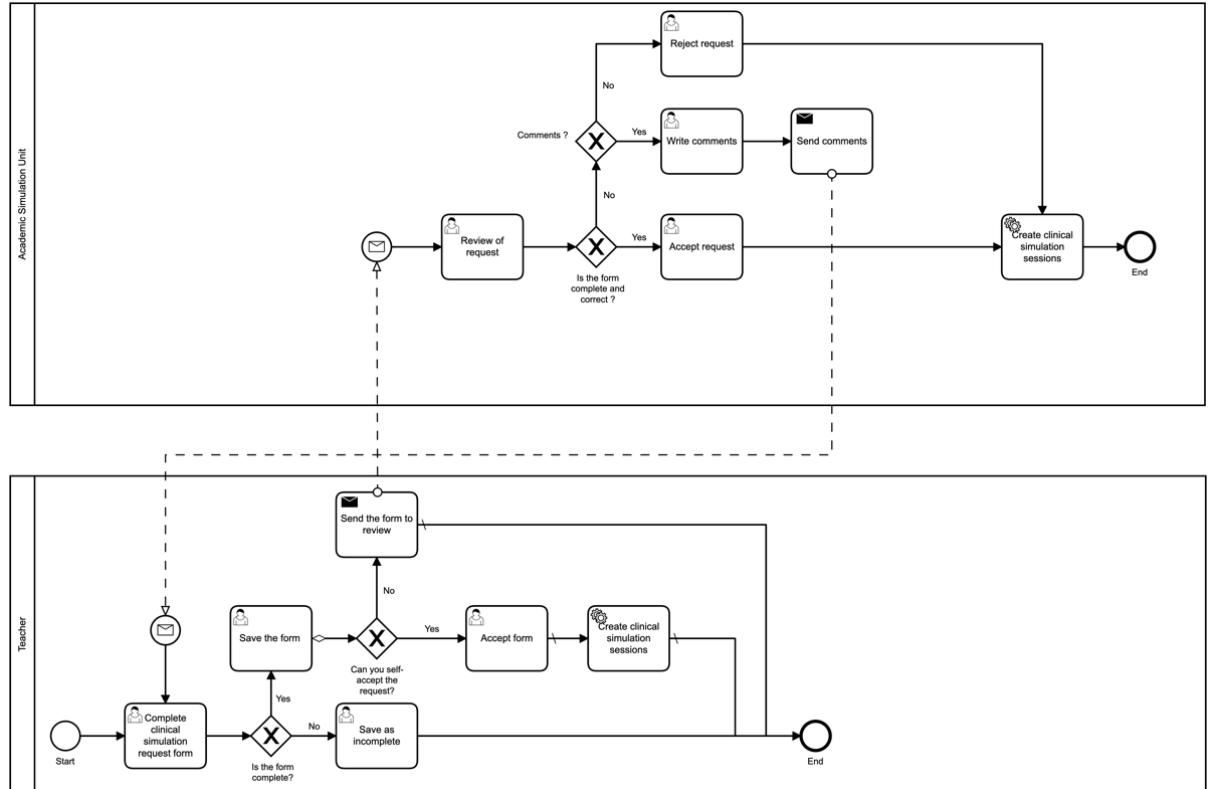
Figure 1. Process of scheduling a simulation session. The Business Process Model and Notation diagram of the process to request a clinical simulation that involves the collaborative work of a teacher with the academic simulation